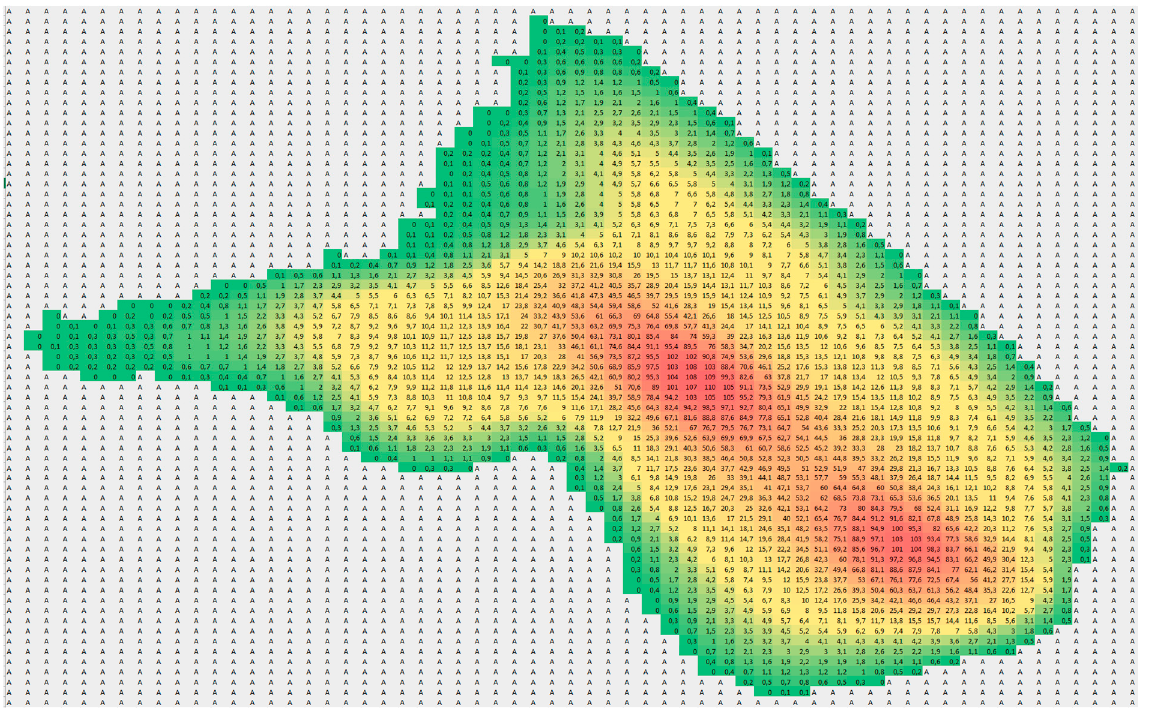
Figure 16. The result of the detection algorithm that normalised the resistance heater thermogram. The red areas correspond to the operating heater. The visible gap in the red area re- veals the element fixing the heater to the rail (pressure handle). The algorithm detects such areas concerning the known geometry of the track and turnout. Based on the image in the visible range and the thermogram, the turnout, resistance heaters, and damage are iden- tified. The multi-sensor recognition allows for the identification of features of the object (Table 4). In the case of EOR system malfunctions, the colour gradient will be unsettled. Particular areas will be classified into the background area and extracted as disturbances. Table 4. Object features in multi-sensor recognition. Own work on the basis of [40].